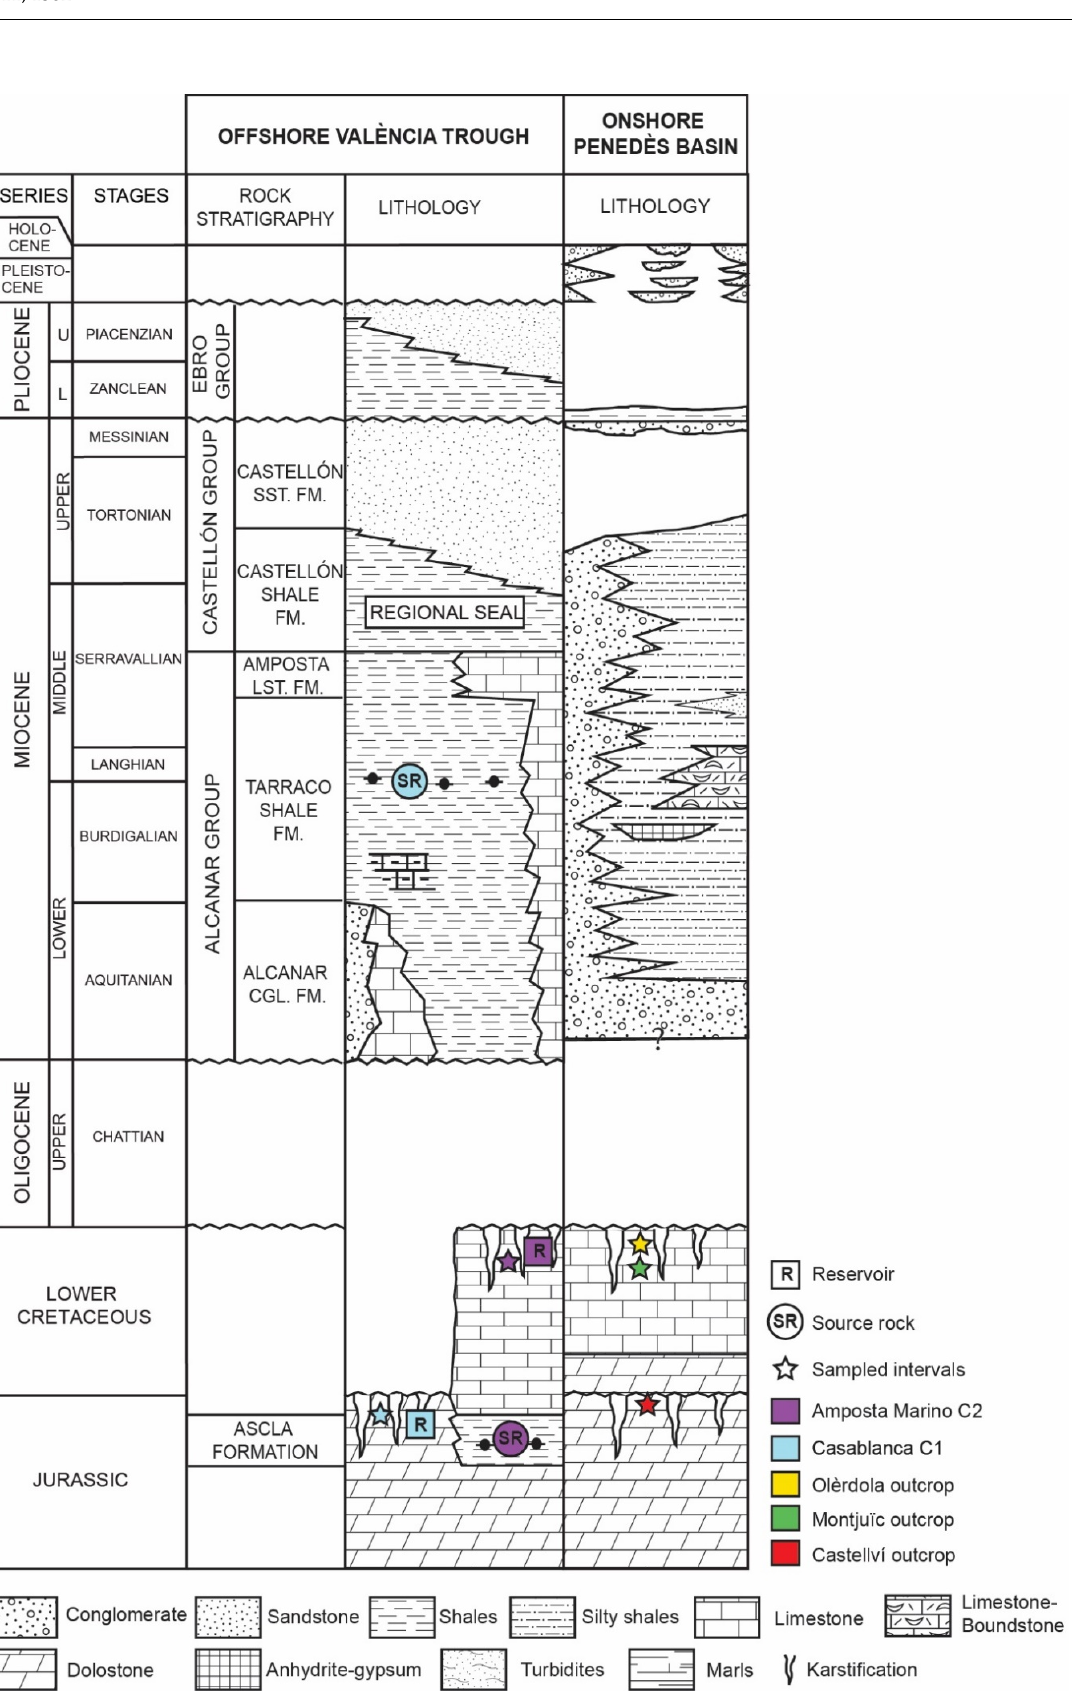
Figure 2. Lithostratigraphy of the offshore Val è ncia Trough and onshore Pened è s Basin. The stratigraphy of the Val è ncia Trough is based on the lithostratigraphic panels of [15,16], as well as the cross-section of [33]. The stratigraphy of the Pened è s Basin is based on the lithostratigraphic panel in